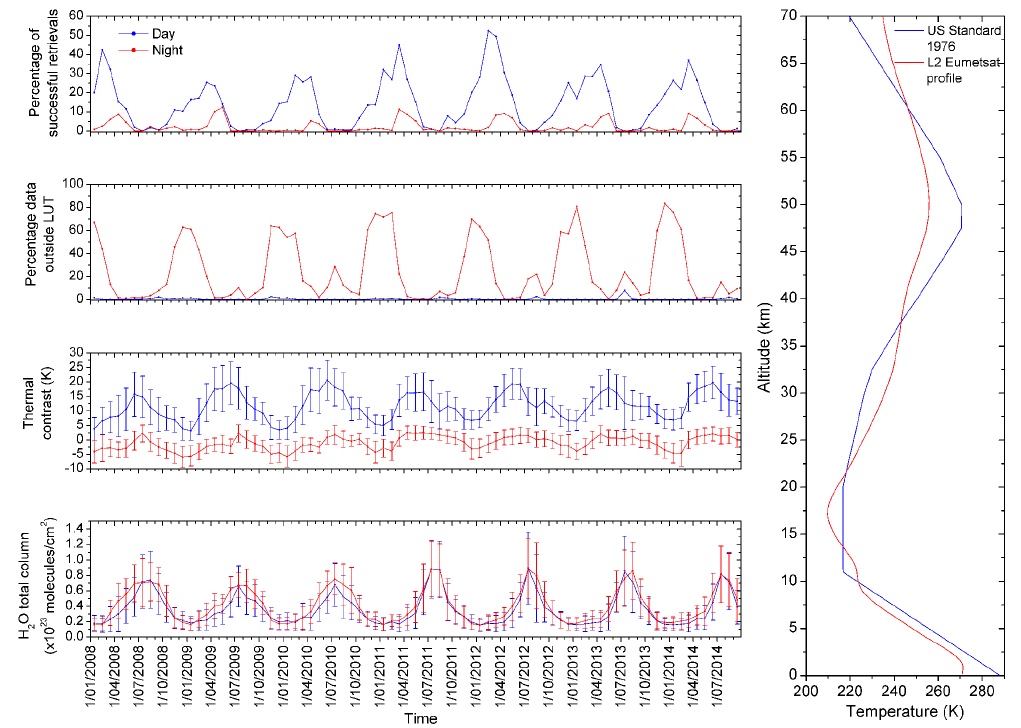
Figure 9. Left panels (from top to bottom): (1) monthly percentage of successful retrievals (see text), (2) monthly percentage of measurements outside the LUT, (3) monthly averages of thermal contrast (K) with associated standard deviations, (4) monthly averages of the total column of H 2 O (moleculescm − 2 ) with associated standard deviations. Daytime measurements correspond to blue and night-time measurements to red. Right panel: temperature vertical profiles of the US Standard 1976 model (blue) and given by the EUMETSAT L2 product (red) for the IASI spectrum recorded above China at 35.81 ◦ N/117.81 ◦ E on 29 December